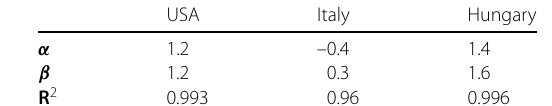
Table 3 Fitting parameters and goodness of the fits shown in Fig. 7, considering the functional form given by the GM model (Eq. (3))